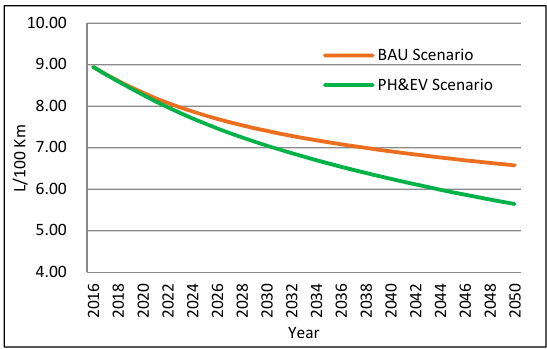
Figure 12. Projected National Fuel Economy, 2016–2050.